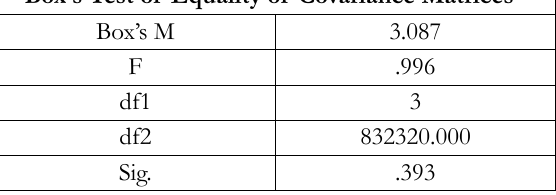
Table 6. Result of homogeneity